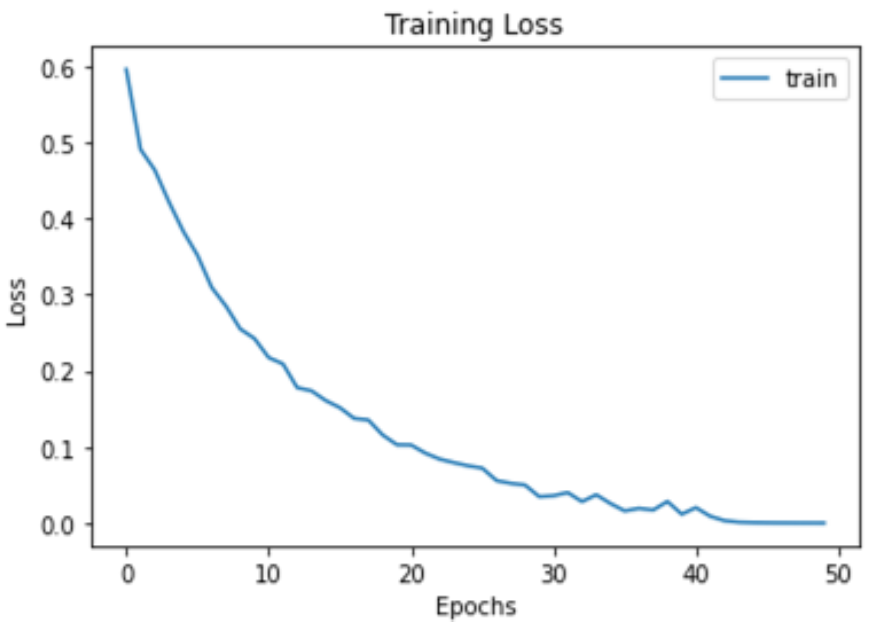
Figure 14. Training loss per epoch.